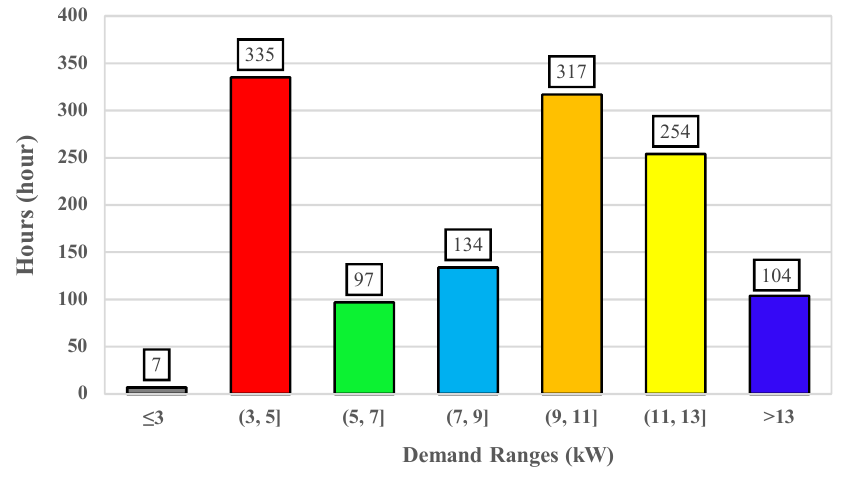
Figure 5. Statistical dispersion of demand for a one-year horizon.